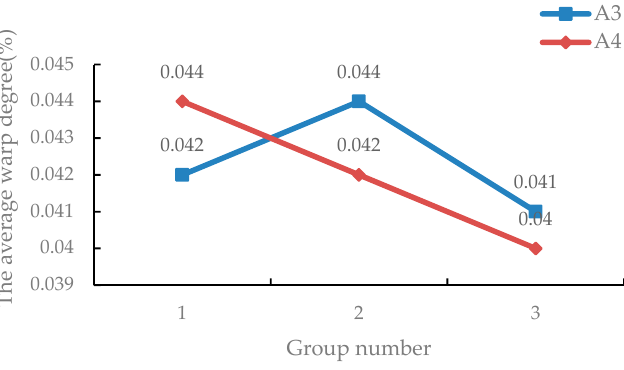
Figure 6 . Effect of moisture content of RSP on panel dimension.